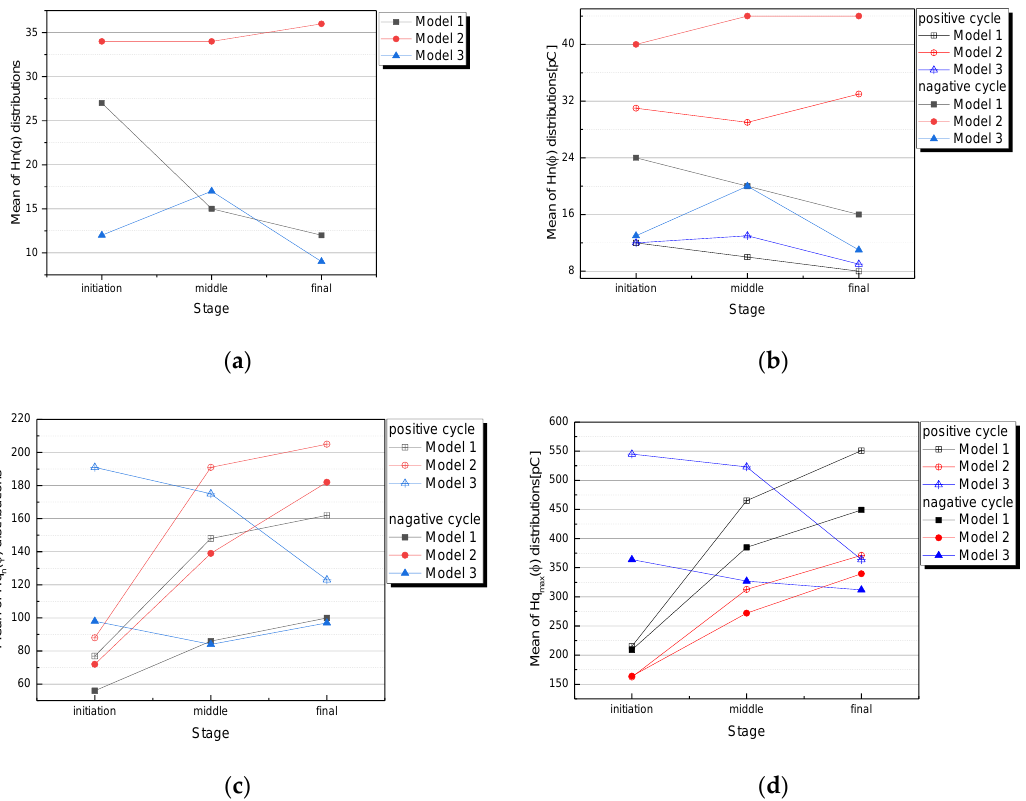
Figure 7. Mean of statistical distributions of PD for tree models: ( a ) Hn(q) distribution; ( b ) Hn(Φ) distribution; ( c ) Hq n (Φ) distribution; ( d ) Hq max (Φ) distribution.